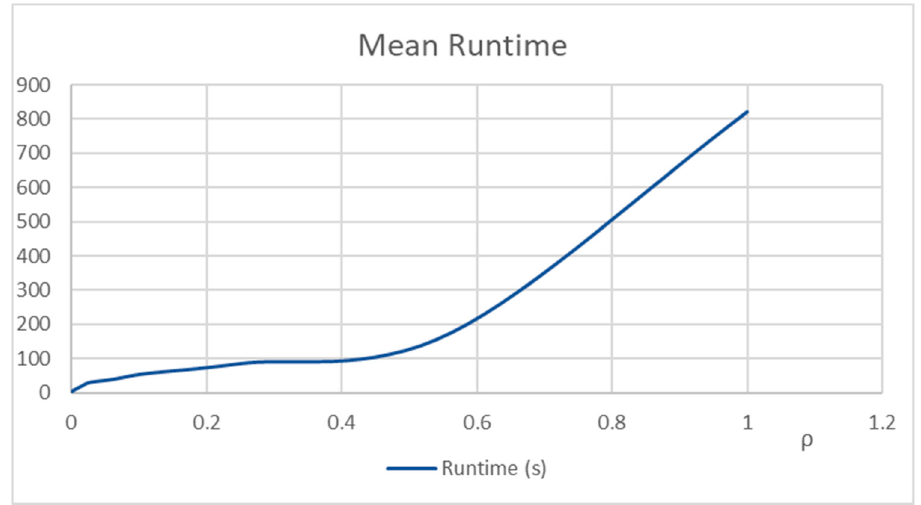
Figure 15. Mean runtime trend.